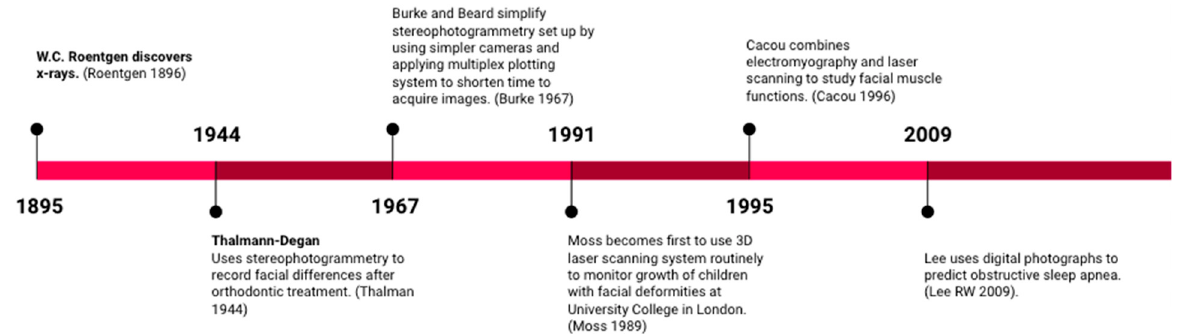
Figure 1. Historical timeline of imaging technology.